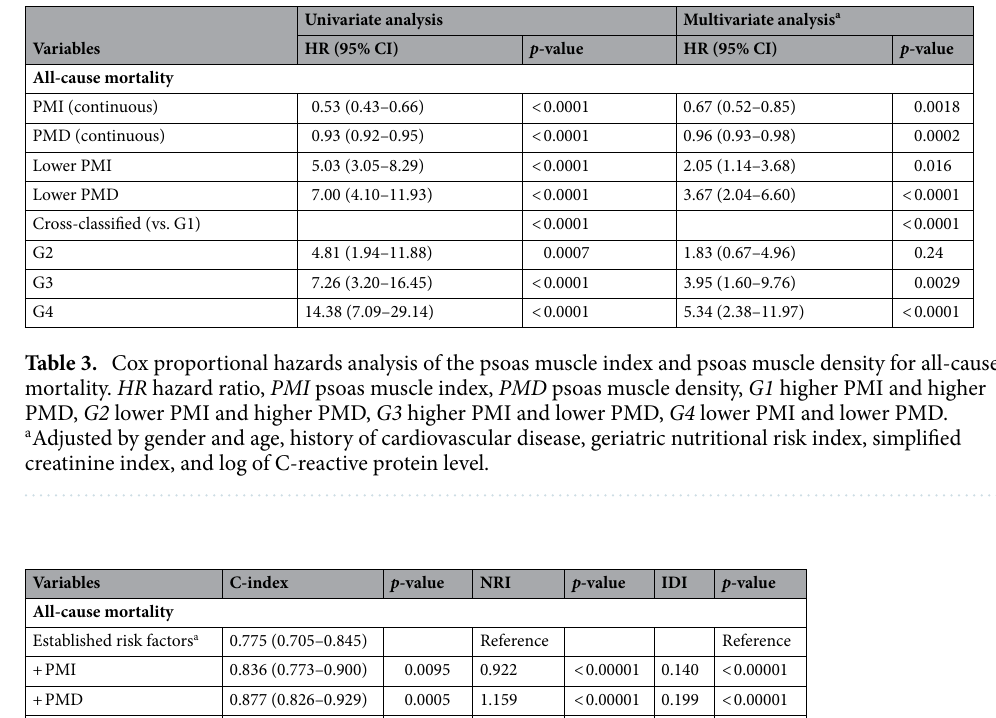
Figure 1. Kaplan–Meier survival curves for all-cause mortality. All-cause mortality for lower PMI vs. higher PMI ( a ), lower PMD vs. higher PMD ( b ), and in the four groups (G1 to G4) with PMI and PMD ( c ). G1 higher PMI and higher PMD, G2 lower PMI and higher PMD, G3 higher PMI and lower PMD, G4 lower PMI and lower PMD, PMI psoas muscle index, PMD psoas muscle density.